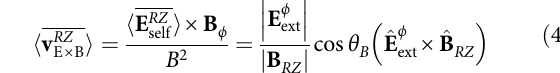
NATURE COMMUNICATIONS| (2018) 9:3523 |DOI: